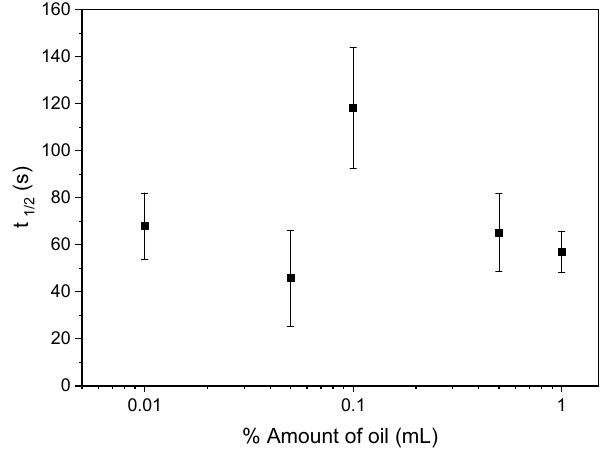
Figure 9. Dependence of the parameter t 1 / 2 on the amount of oil present with data points corresponding to mean values and their standard deviation values (error bars) from three experiments.